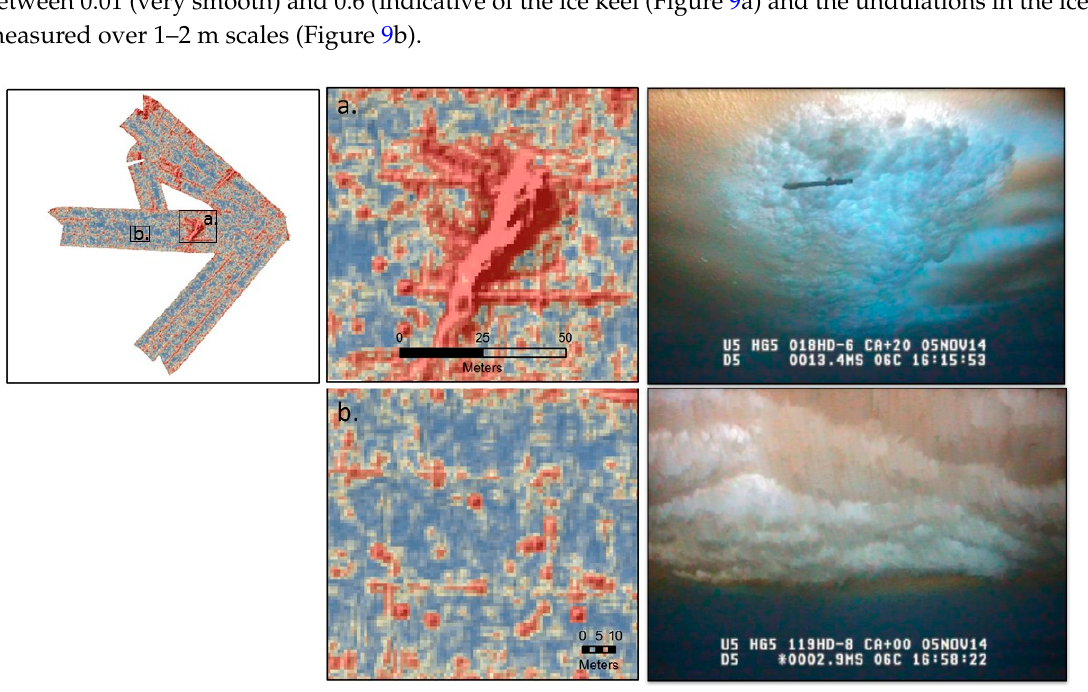
Figure 9. Sea ice ruggedness estimates showing ( a ) an ice keel (2–3 m thick); and ( b ) undulations in the ice surface (1–2 m in length scale). Validation imagery collected with a remotely operated vehicle (ROV) show the pressure keel from below and an example of the undulations in this location.